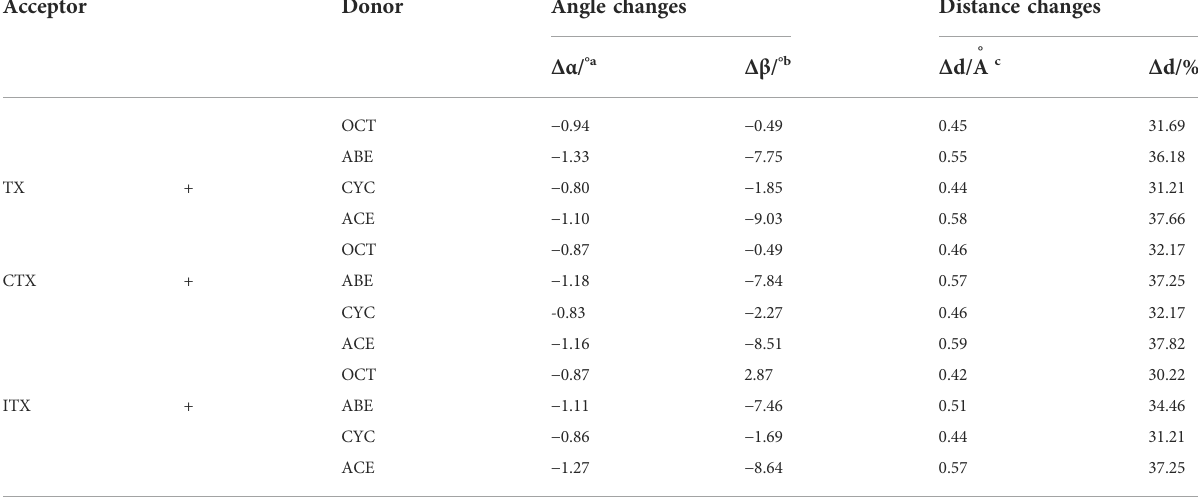
TABLE 1 Changes in bond angles and distances between the reaction complex (RC) and the transition state (TS). Acceptor